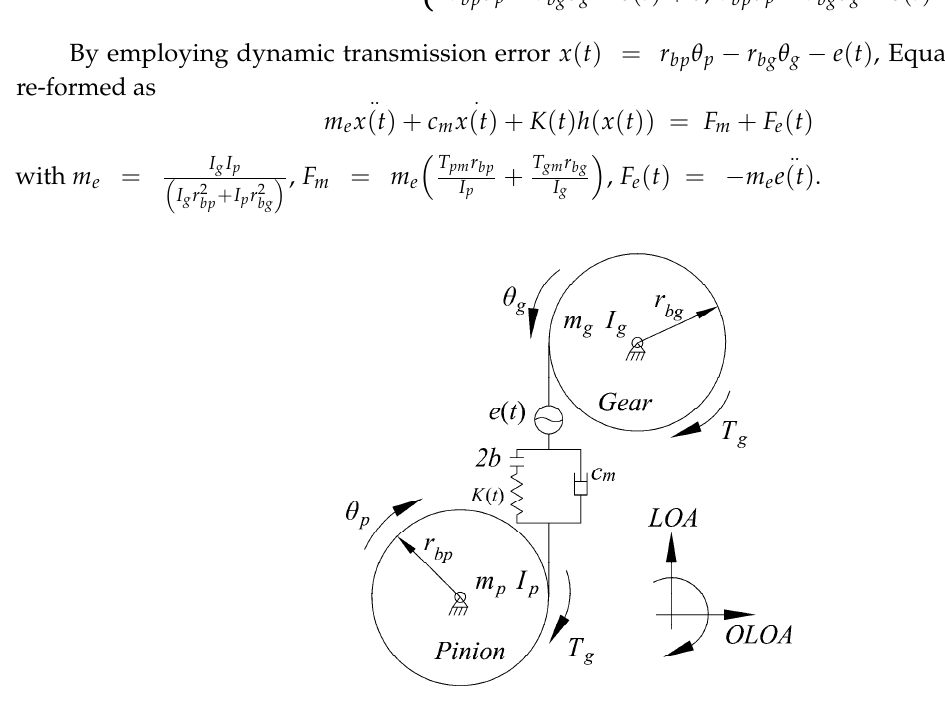
Figure 8. The non-linear dynamic model.